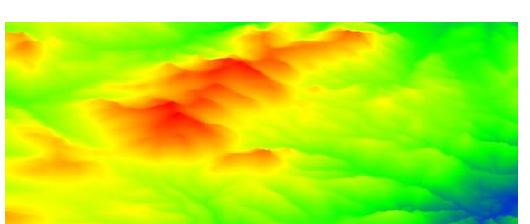
Figure 4: Portion of DEM used in these Experiments